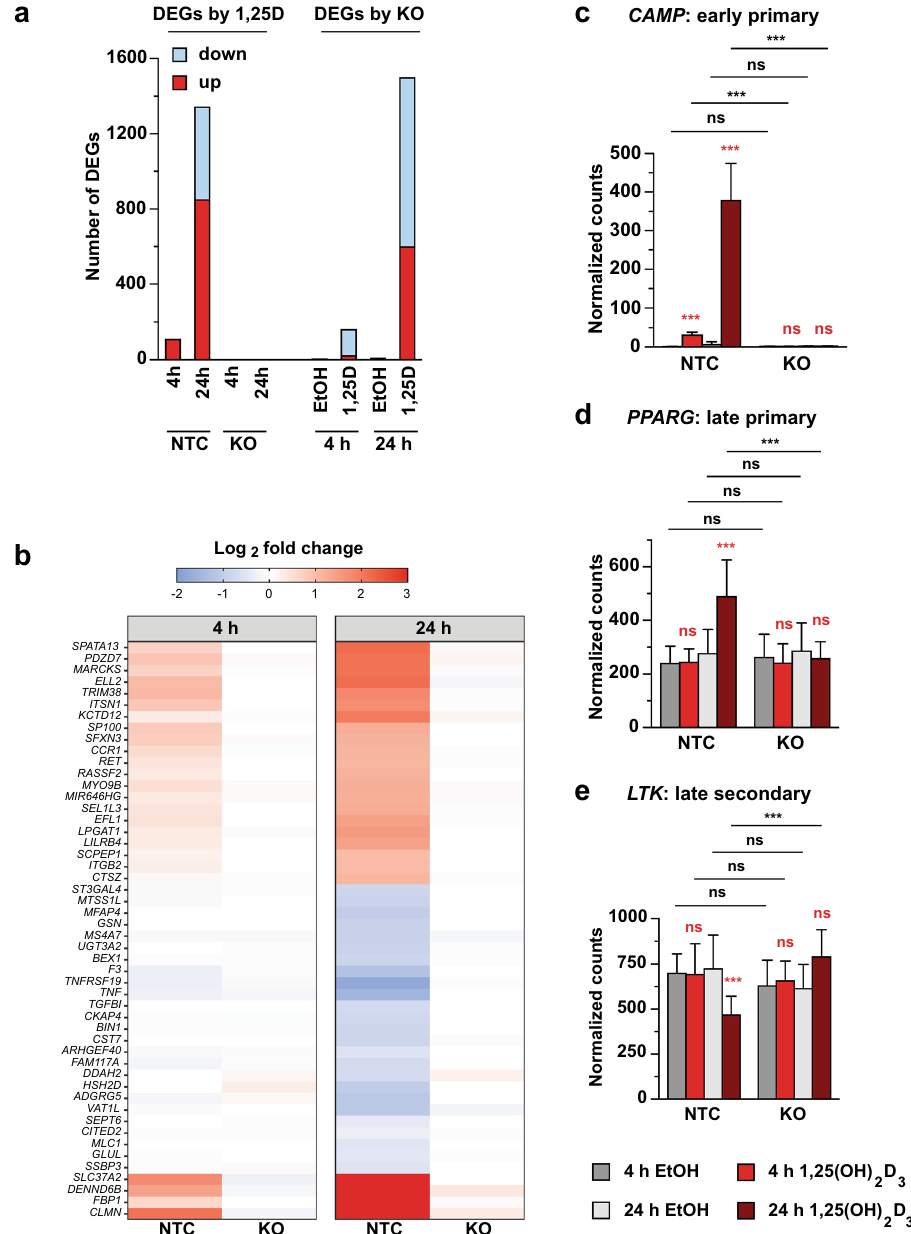
Figure 2. VDR knockout abolishes transcriptomic vitamin D response. The VDR was knocked out by CRISPR/ Cas9 genome editing in THP-1 cells. VDR knockout (KO) cells and control (NTC) cells were treated with 1,25(OH) 2 D 3 or solvent (EtOH) for 4 or 24 h and four biological repeats of RNA-seq have been performed. The numbers of DEGs by either the 1,25(OH) 2 D 3 stimulation or the VDR knockout are displayed ( a ). The log2 fold changes in gene expression of the top 50 most significant DEGs in both VDR KO and NTC control cells demonstrates the almost complete loss of 1,25(OH) 2 D 3 inducibility ( b ). There rarely is any effect of the VDR KO on the basal expression levels of vitamin D target genes, which is shown for some exemplary genes ( c–e